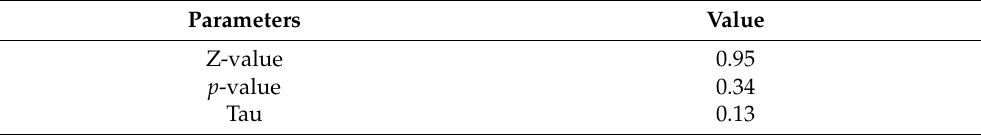
Table 2. Mann–Kendall Trend test yearly total precipitation for the whole study area. Parameters Value